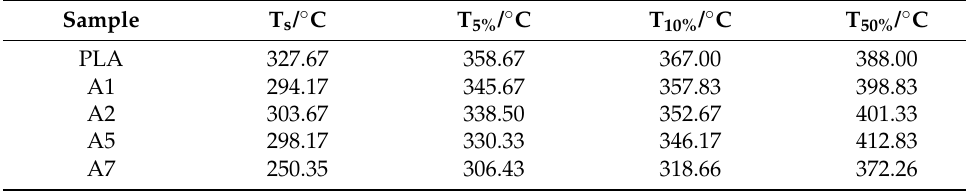
Figure 6. Thermogravimetric analysis of different PLA/PBS composites: ( a ) TG curves and ( b ) DTG curves. Table 2. Thermal decomposition temperature of PLA and composites. Table 2. Thermal decomposition temperature of PLA and composites.